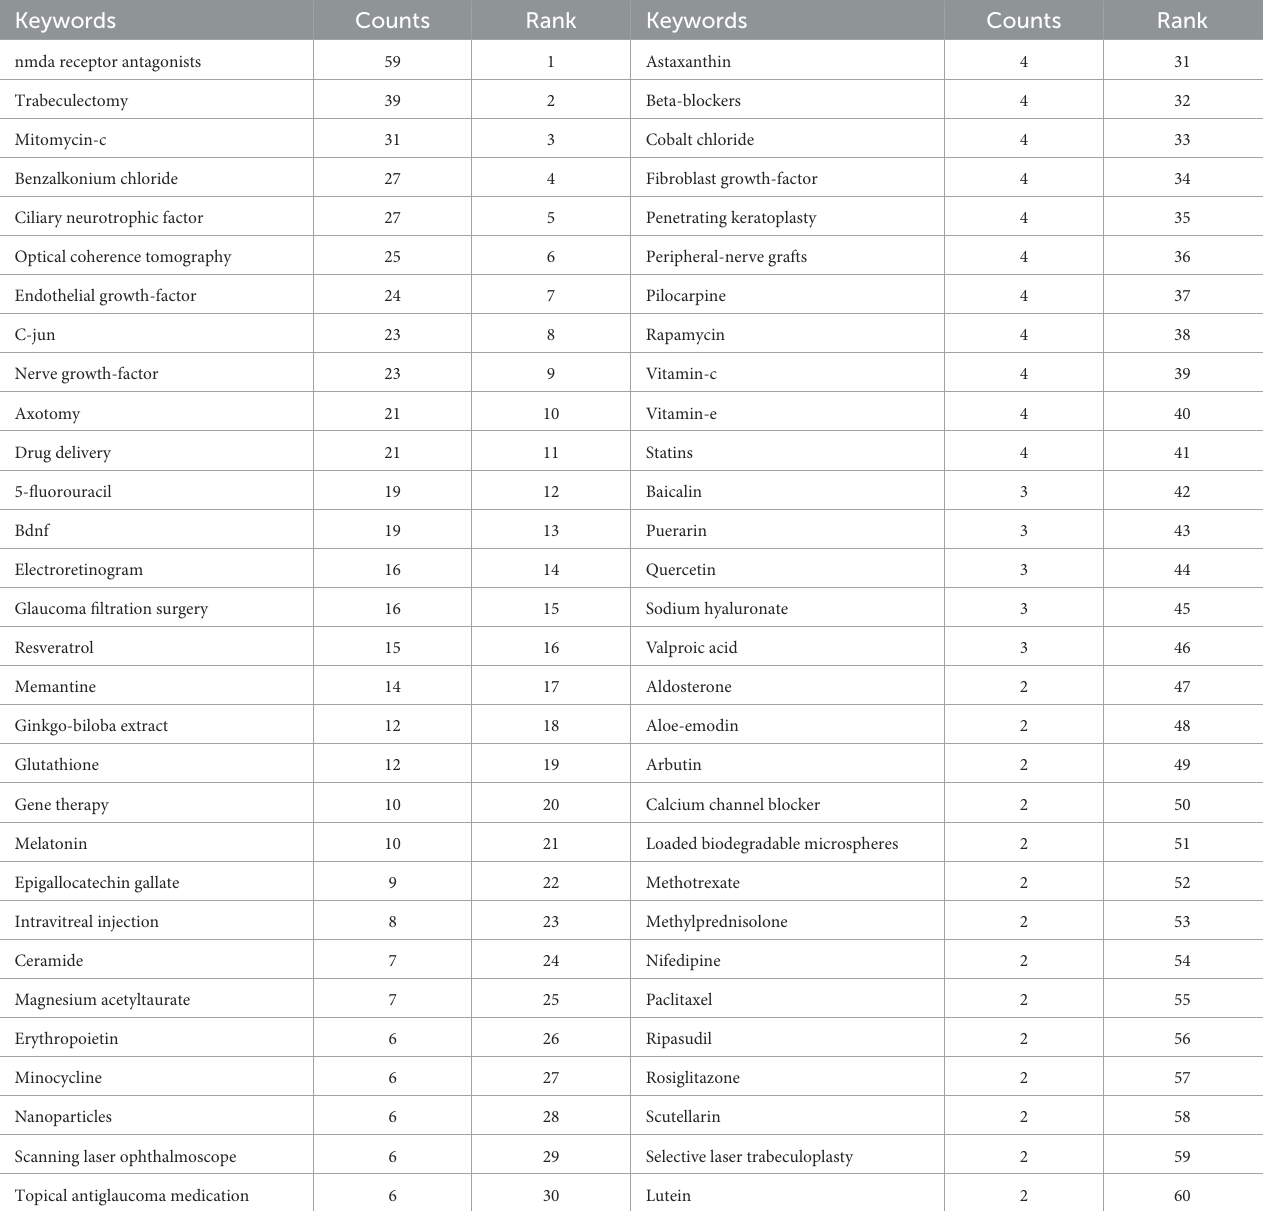
TABLE 8 The top 60 keywords related to glaucoma